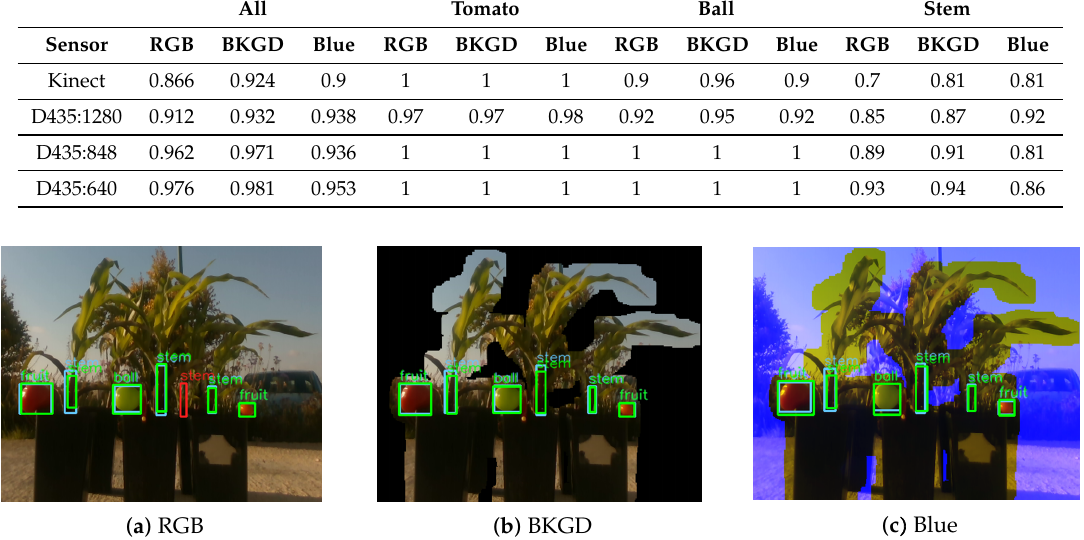
Figure 6. I NTEL D 435:848 detection examples for each method. The blue bounding box denotes the ground truth, the green bounding box denotes a true positive prediction, and the red bounding box denotes a false positive prediction.